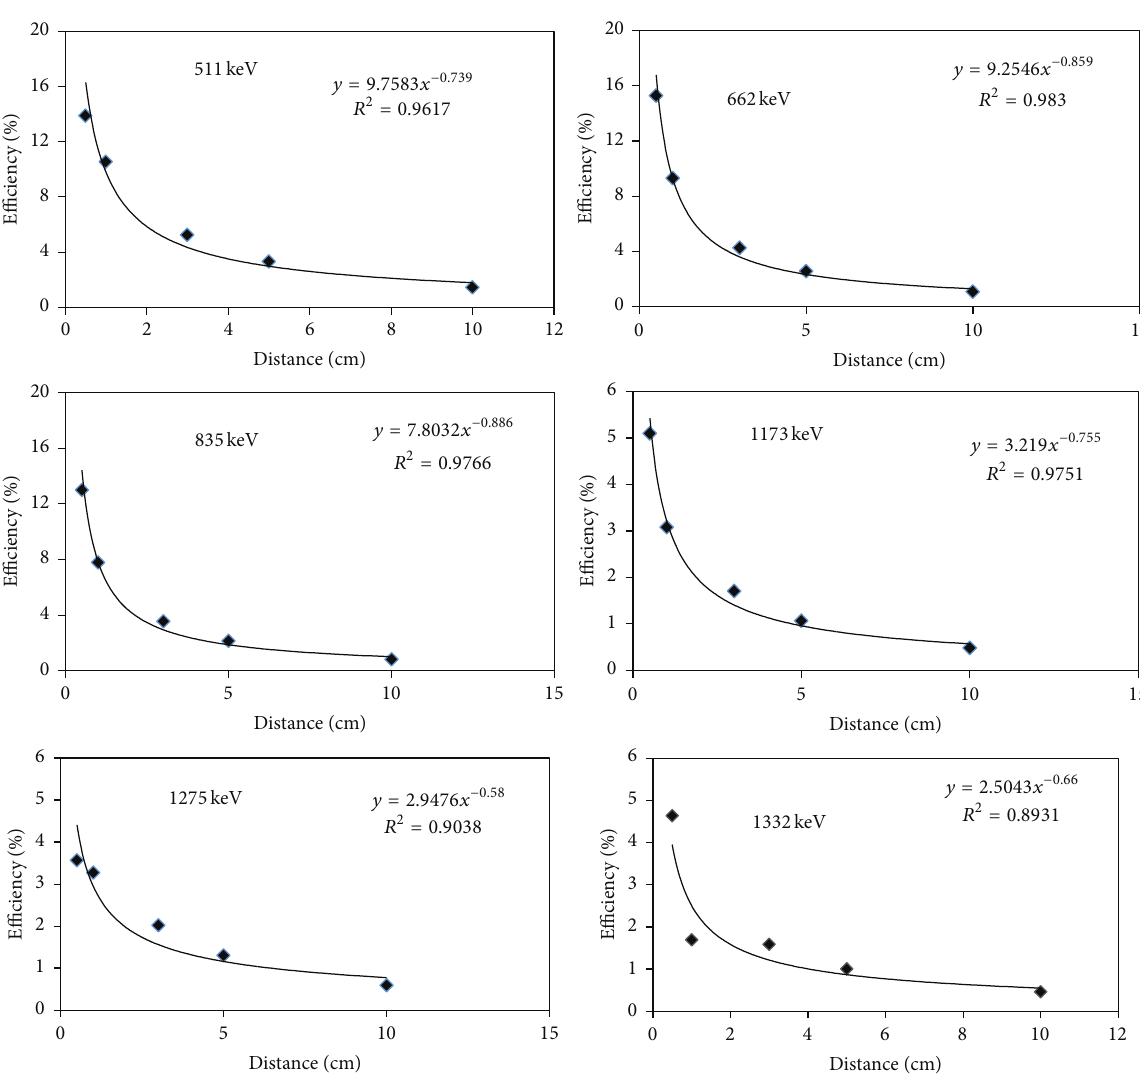
Figure 5: Variation of detection efficiency of NaI(Tl) detector as a function of